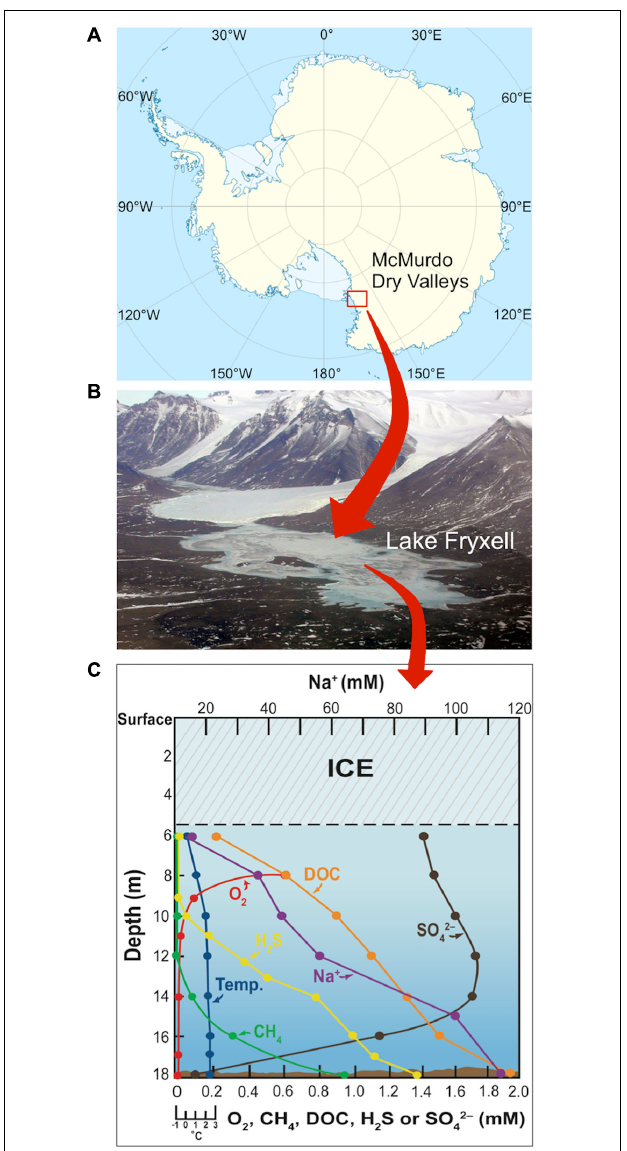
FIGURE 1 | Geomorphology and physicochemistry of Lake Fryxell, Antarctica. (A) Site of the McMurdo Dry Valleys of East Antarctica. (B) Aerial view of Lake Fryxell in Taylor Valley. (C) Physicochemistry of the highly stratified Lake Fryxell water column (adapted from Sattley and Madigan, 2010). DOC, dissolved organic